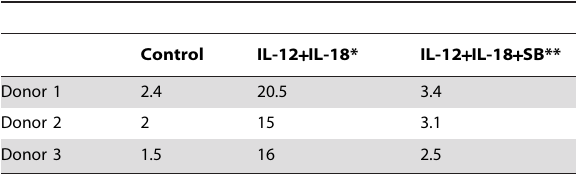
Table 2. Percentage of IFN- c + cells from CD4 + RA + IL-18R a + T cells as determined by intracellular staining.